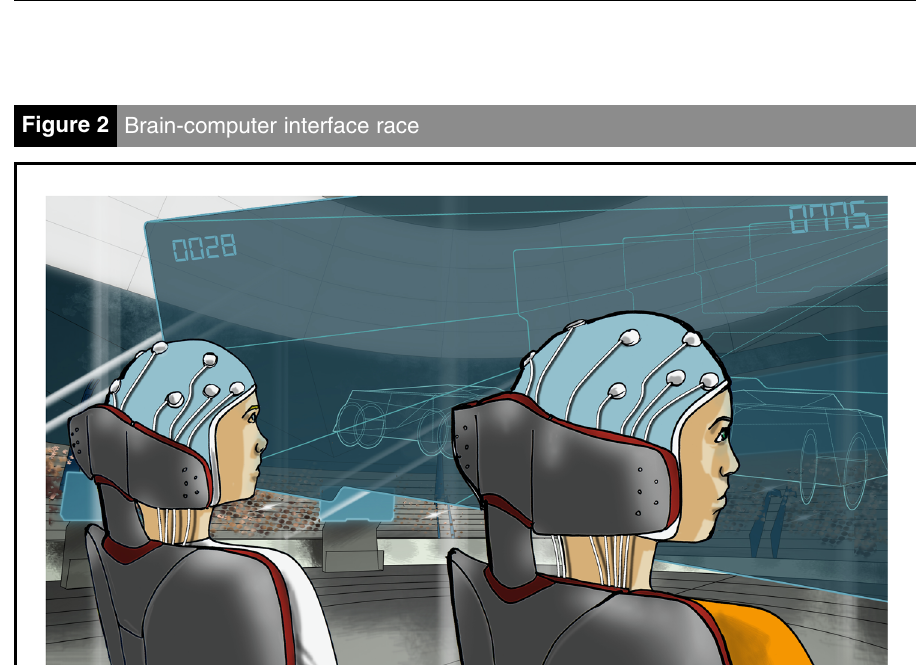
Figure 2 Brain-computer interface race